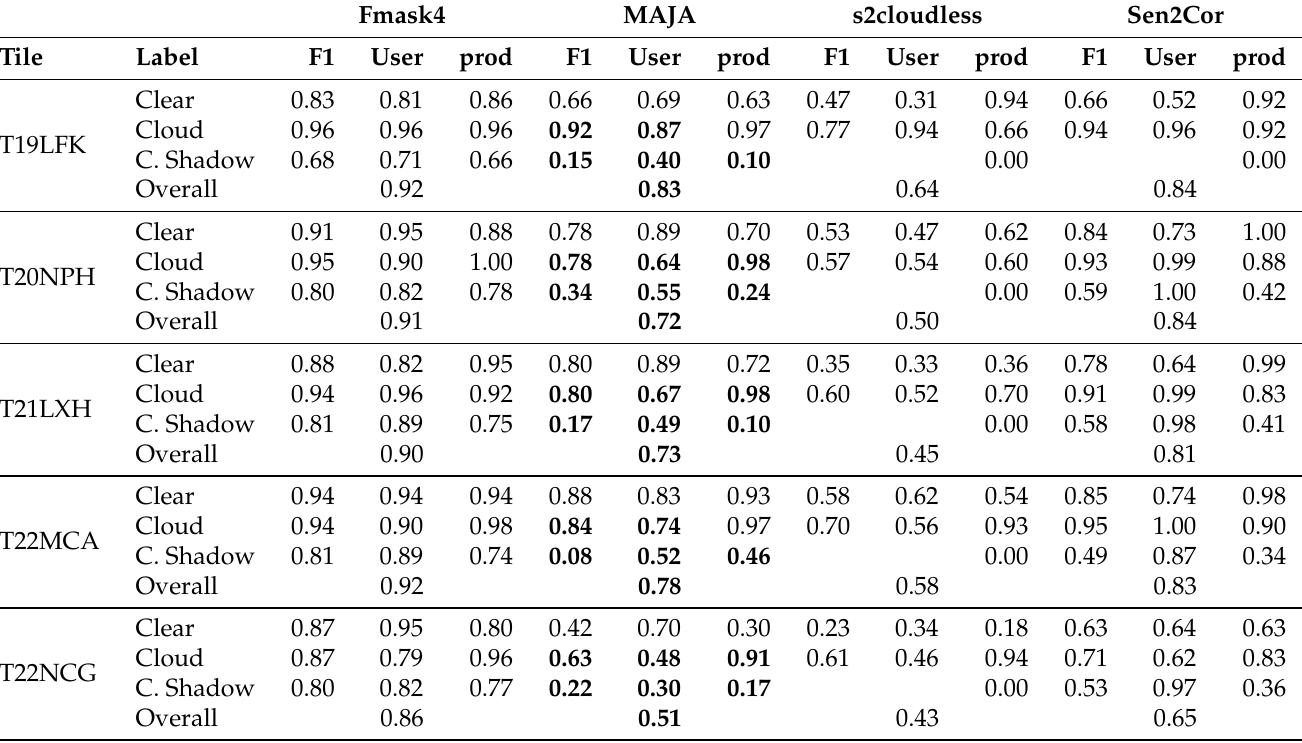
Table 4. Updated version of Table 4 [1] with updated values of MAJA (in bold face). User and producer accuracies for each tile and cloud-detection